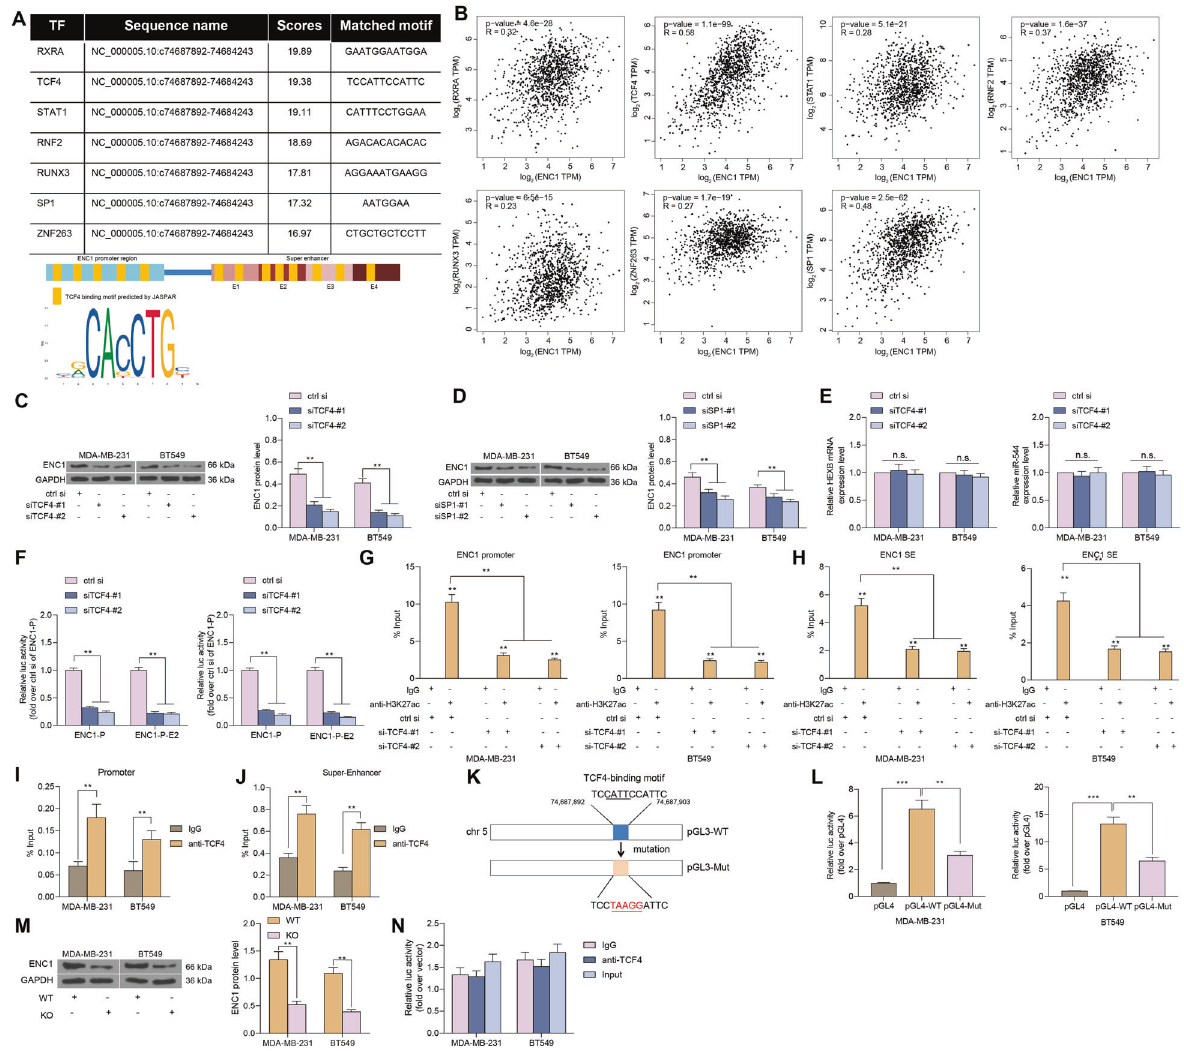
Fig. 5 SE-associated ENC1 is transcriptionally activated by TCF4. A Transcription factors that bind to the ENC1-P as well as the SE regions predicted by the JASPAR website (upper) and binding sites of TCF4 to ENC1-P and ENC1-SE and conserved binding sequences of TCF4 predicted by JASPAR website (down). B Correlations between expression of seven transcription factors and ENC1 expression in the TCGA- BRCA database analyzed by Spearman ’ s correlation test. C , D The ENC1 expression in MDA-MB-231 and BT549 after knocking down the expression of TCF4 ( C ) and SP1 ( D ) determined by western blot. E The expression of HEXB and miR-544, located in the same chromosomal region of ENC1, in MDA-MB-231 and BT549 cells after knockdown of TCF4 or SP1 determined by RT-qPCR. F Detection of luciferase activity in ENC1-P and ENC1-P-SE2 in MDA-MB-231 and BT549 cells after knockdown of TCF4. G , H The level of H3K27ac modi fi cations in the ENC1-P ( G ) and ENC1-E2 ( H ) after knockdown of TCF4 determined by ChIP-qPCR. I , J The binding relationship between TCF4 and ENC1-P ( I ) and ENC1-E2 ( J ) examined by ChIP. K schematic representation of a 241 bp region of the ENC1 enhancer (from chr5: 74687892-74684243) containing the TCF4-wt motif binding sequence or the mut alleles. L BC cells were transfected with the plasmids for 2 d. The luciferase activity levels were normalized to pGL4 luciferase activity. M After constructing cell lines with ENC1-P and ENC1-SE knock out using the Crispr-Cas9 system, the expression of ENC1 in cells was detected by western blot. N ChIP-qPCR in MDA-MB-231 and BT549 cells with ENC1-P and ENC1-SE knock out using anti-TCF4 antibody. Data are representative of 3 separate experiments performed in triplicate. All the data are expressed as the mean ± SD. Two-way ANOVA with Tukey ’ s multiple comparison test were utilized to detect signi fi cant differences between data. ** p < 0.01, *** p < 0.001, ns, nonsigni fi